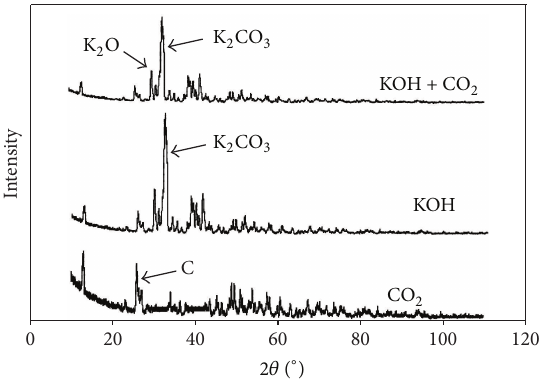
Figure 4: XRD patterns of activated carbons from raw coconut shell by one step gasification method (without the carbonization step) under the same conditions by using different oxidizing